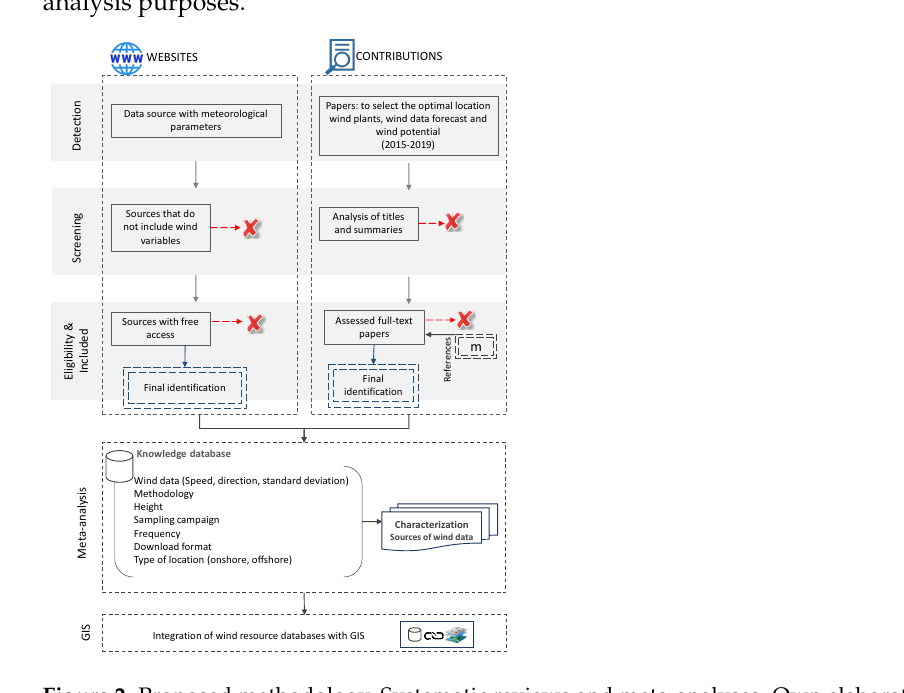
Figure 2. Proposed methodology. Systematic reviews and meta-analyses. Own elaboration.